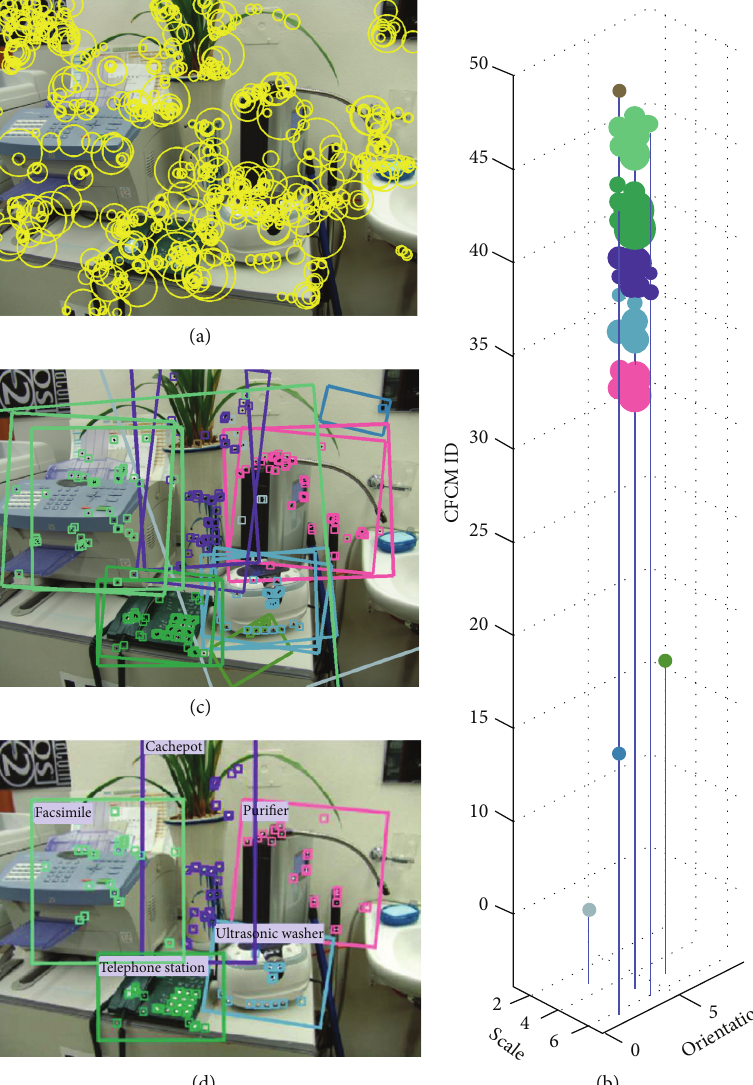
Figure 10: Hypothesis and test based object recognition examples: (a) input image with the detected features, (b) Hough space, (c) hypothesized objects, and (d) final object recognition results.